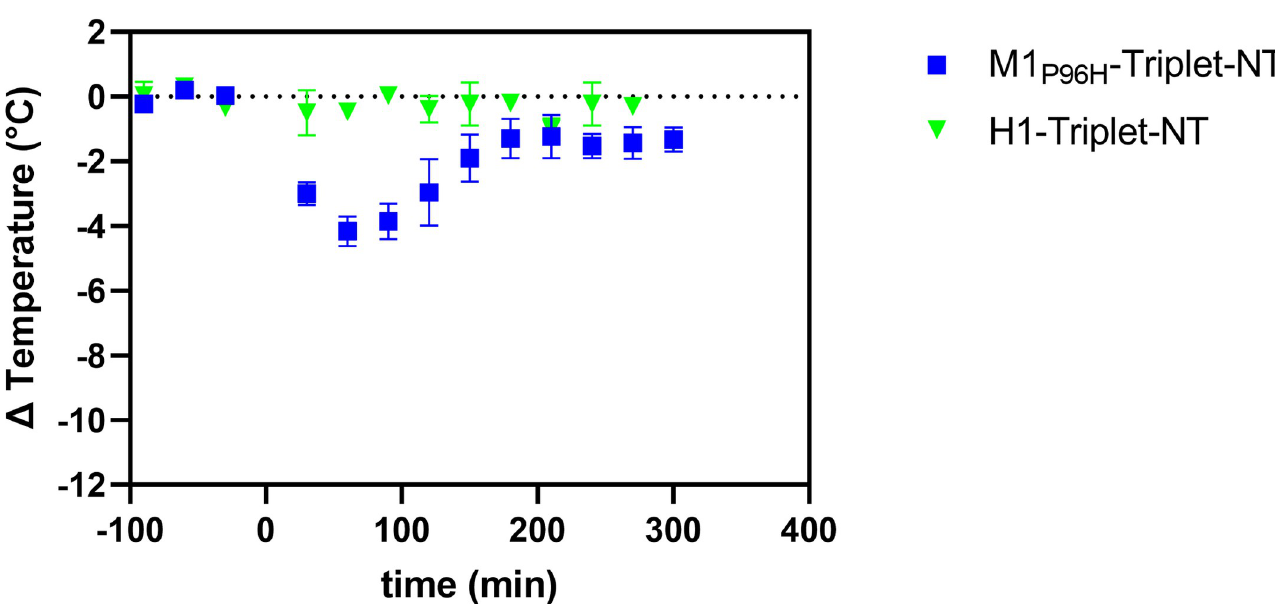
Fig 6. Measurement of M1 P96H -Triplet-NT and H1-Triplet-NT hypothermia effect. M1 P96H -Triplet-NT and H1-Triplet-NT were injected at dose of 600nmol/ kg body weight (n = 3). M1 P96H -Triplet-NT caused a temperature drop of about 4C˚ and H1-Triplet-NT caused no temperature drop.